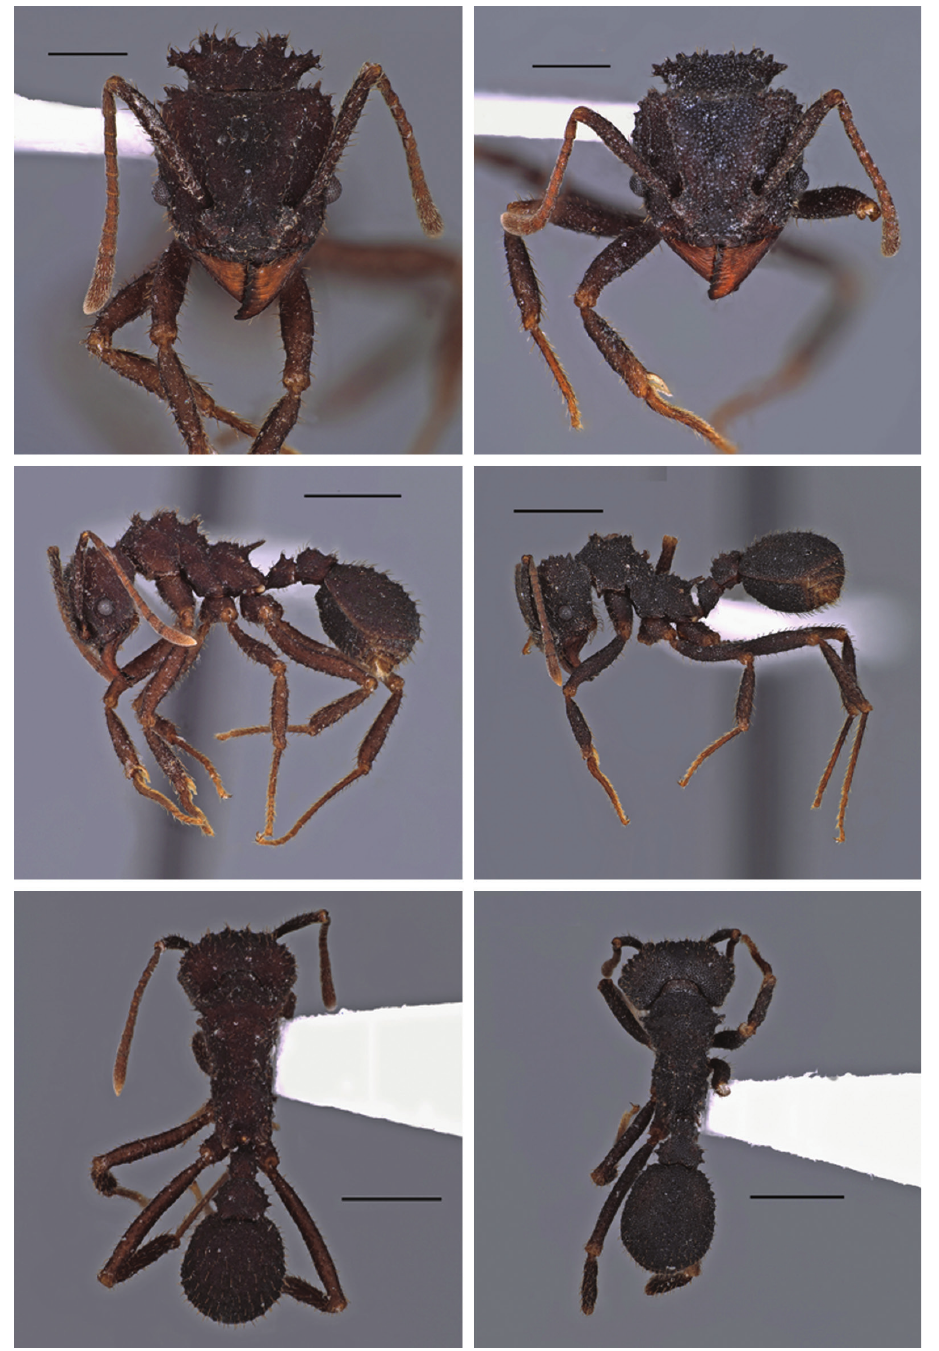
Figure 2. Full face (top row), lateral (middle row) and dorsal (bottom row) views of Trachymyrmex pakawa and Trachymyrmex smithi . Left column, T. pakawa . Right column, T. smithi . Scale bars: top, 0.5 mm; middle and bottom, 1.0